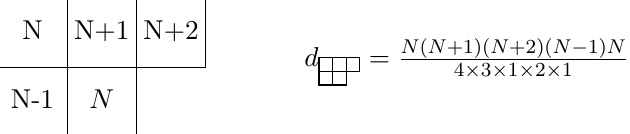
Figure 6. Example of the computation of the dimension of an irreducible representation of SU( N